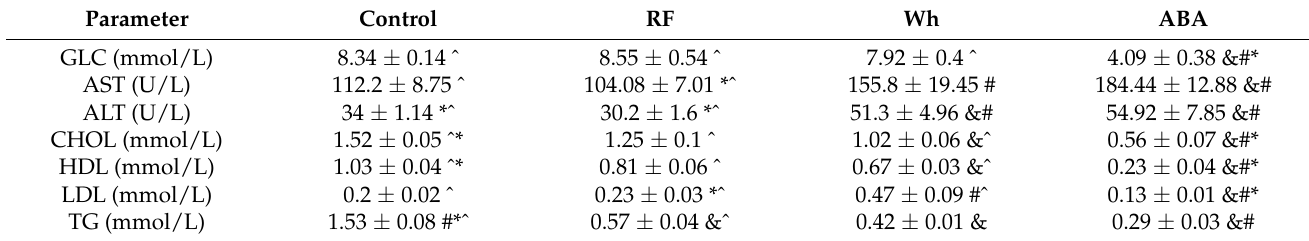
Table 2. Biochemical analysis of the blood samples collected from 49 rats (both females and males). Data expressed as mean ± SEM. Statistically significant difference marked as: &—vs. C, #—vs. RF, *—vs. Wh, ˆ—vs. ABA (a one-way Welch